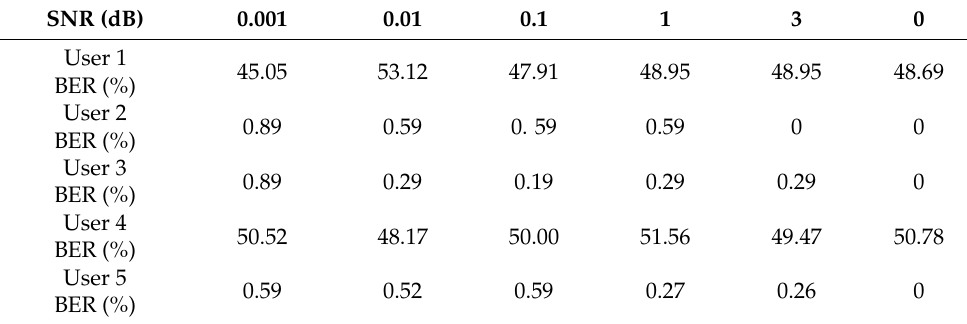
Table 6. BER between plain text and decrypted text for noise